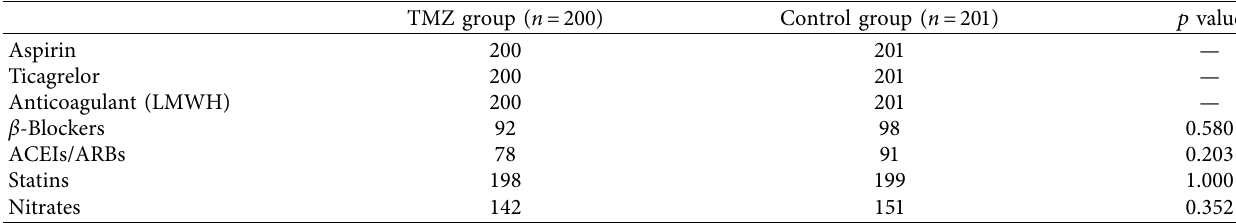
Table 2: Pharmacologic treatments.